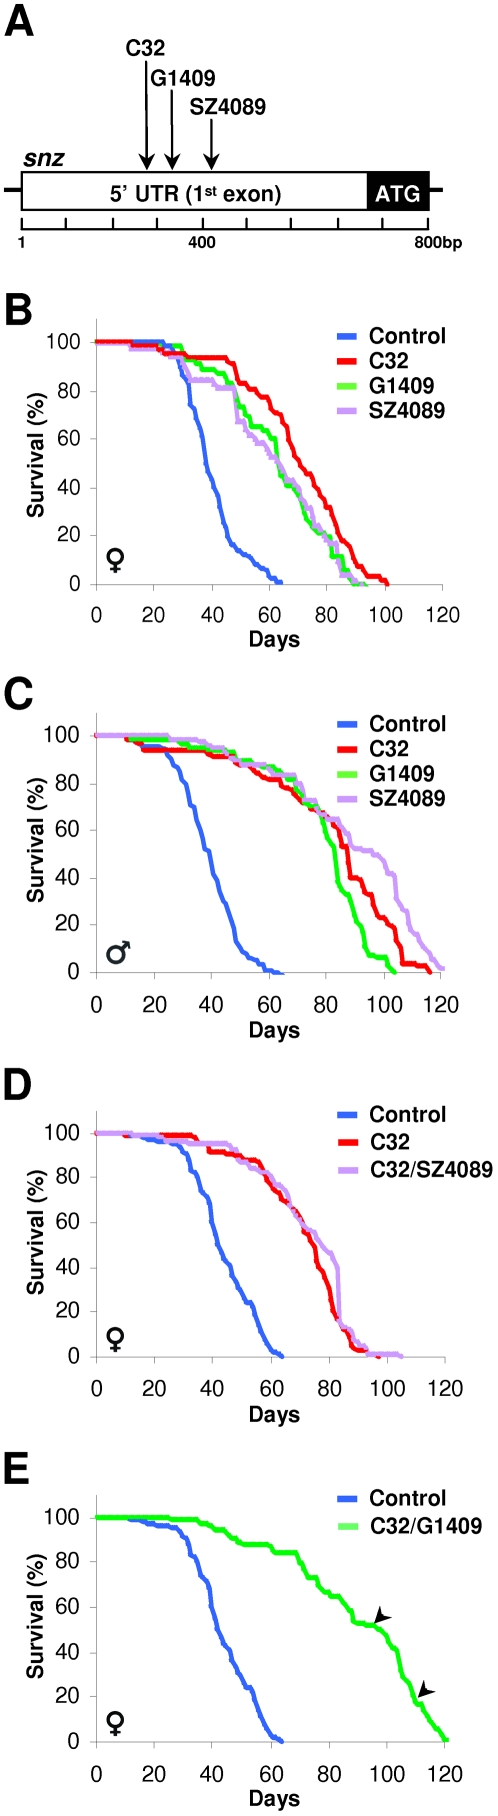
Independent snz Alleles Are Long-lived.(A) Location of the C32, G1409, and SZ4089 P-element insertions in the snazarus locus. (B, C) Female (B) and male (C) control, C32, G1409, and SZ4089 flies were cultured and survival was plotted. (n>80) (D, E) The lifespan of control, C32 as well as C32/SZ4089 (D) and C32/G1409 (E) female transheterozygotes was assessed and plotted. (n>80) p<0.0001 by log-rank test between control and all snz mutant alleles. Arrowhead indicates fertility at observed timepoint. Representative data from multiple experiments is shown.